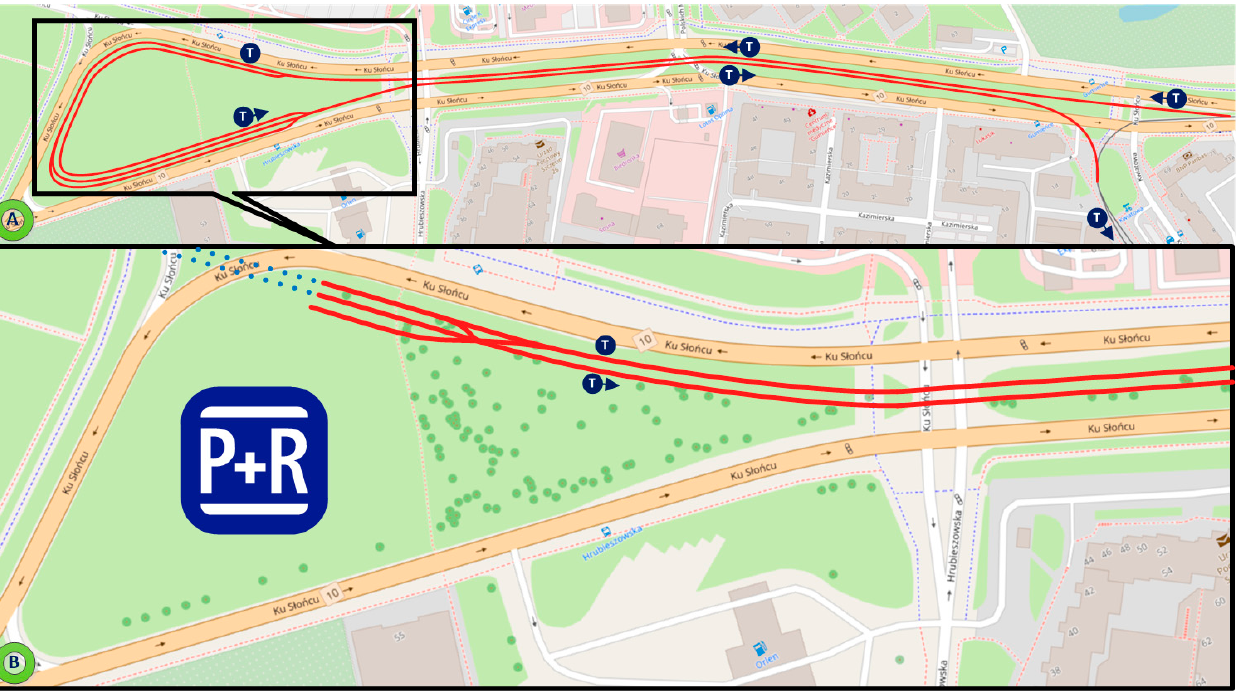
Figure 16. Application of the bi-directional tram as an alternative approach to the development project (tram route extension in the Gumie´nce district in Szczecin) (own study based on openstreetmap.org). route ca. 4.9 km in length running between Bohater ó w Warszawy Street and the Krzekowo tram loop on ˙Zołnierska Street (the planned route is marked in red in part A of Figure